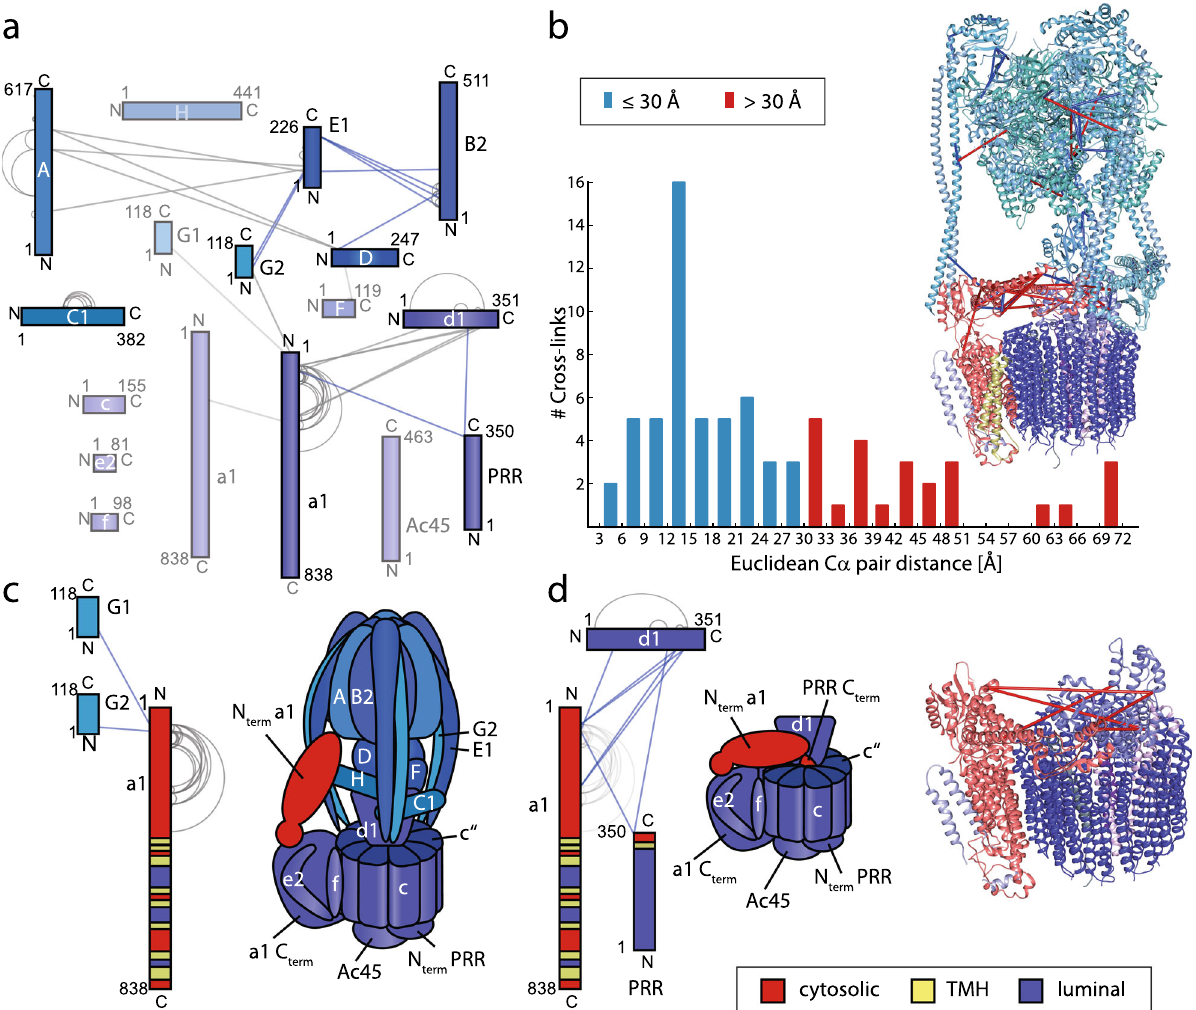
Fig. 2 Protein interactions in the V-ATPase complex. a Proteins are shown as coloured bars. The length of the bars corresponds to the protein length. Cross-links identi fi ed within (grey) or between (blue and grey) ATPase subunits are shown in an interaction network. Inter-molecular cross-links identi fi ed in one (grey) or at least two (blue) biological replicates are shown. b 74 out of 78 observed cross-links could be mapped onto the available high-resolution structure of the V-ATPase complex from rat brain (PDB ID 6VQ6). Cross-linking distances and the number of cross-links obtained from at least one biological replicate that satisfy these distances are plotted in a histogram. 50 cross-linked amino acid residues showed distances <30 Ȧ (blue). Long- distance cross-links (red) were mostly observed in fl exible protein subunits. Note that cross-links of subunits that are present in multiple copies are only mapped once. c Inter-molecular cross-links between subunit a1 and subunit G1/G2 supporting the active conformation are shown. The N-terminal domain of a1 is highlighted in red. A structural cartoon of the V-ATPase is shown for comparison. d Cross-links between subunit a1 and subunits d1 and PRR supporting the closed, inhibitory conformation are shown. The N-terminal domain of a1 as well as the C-terminal, cytosolic peptide of PRR are highlighted in red. A structural cartoon of this conformation is shown. A section of the high-resolution structure showing long-distance cross-links supporting the closed conformation is shown. Note that PRR K346 is missing in the high-resolution structure and cross-links between V-ATPase-a1 and PRR cannot be shown. Legend to panels ( c ) and ( d ): cytosolic, cytosolic part; TMH, transmembrane helix; luminal, luminal